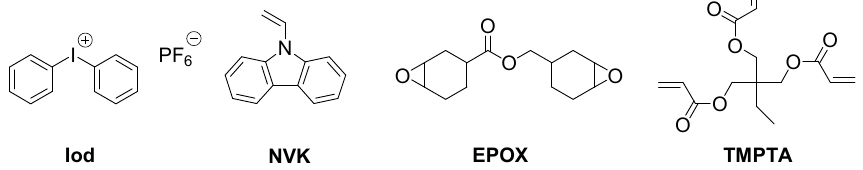
Figure 5. Monomers and additives used with Cu-1 – Cu3 .